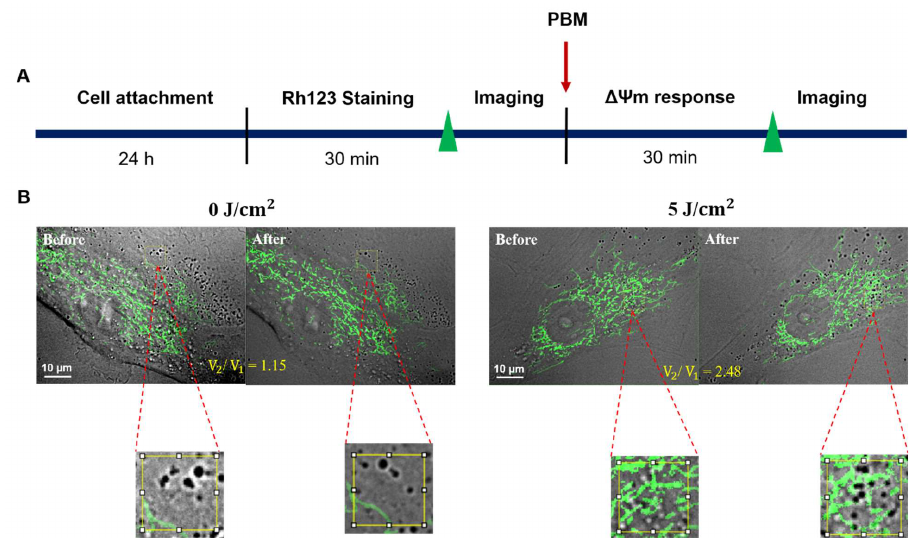
Figure 9. ( A ) Experimental procedures in vesicle transport investigation on the irradiated-hADSCs ( B ) The mergence between bright field and fluorescence images in promoting the vesicle transport in the irradiated-hADSCs (Passage 10) after 30 min treatment at a fluence of 5 (J/cm 2 ) compared to control 0 (J/cm 2 ). The ROI area (64 × 64 pixels) was identified by ImageJ, followed by cutting it and measure the velocity using (Matlab R2021a).